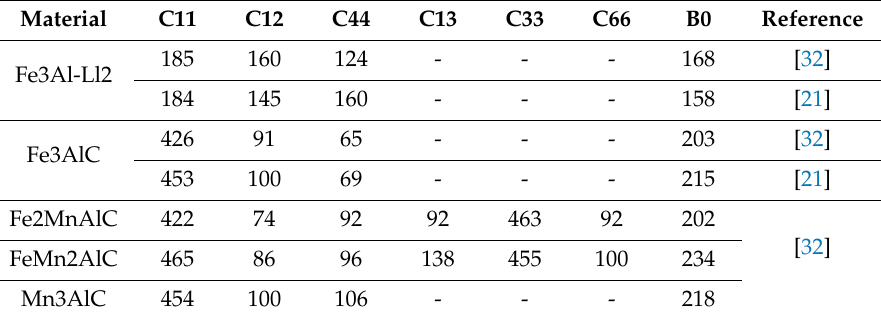
Table 2. The elastic constants and bulk modulus of Fe 3 Al- L l 2 and κ -carbides (in